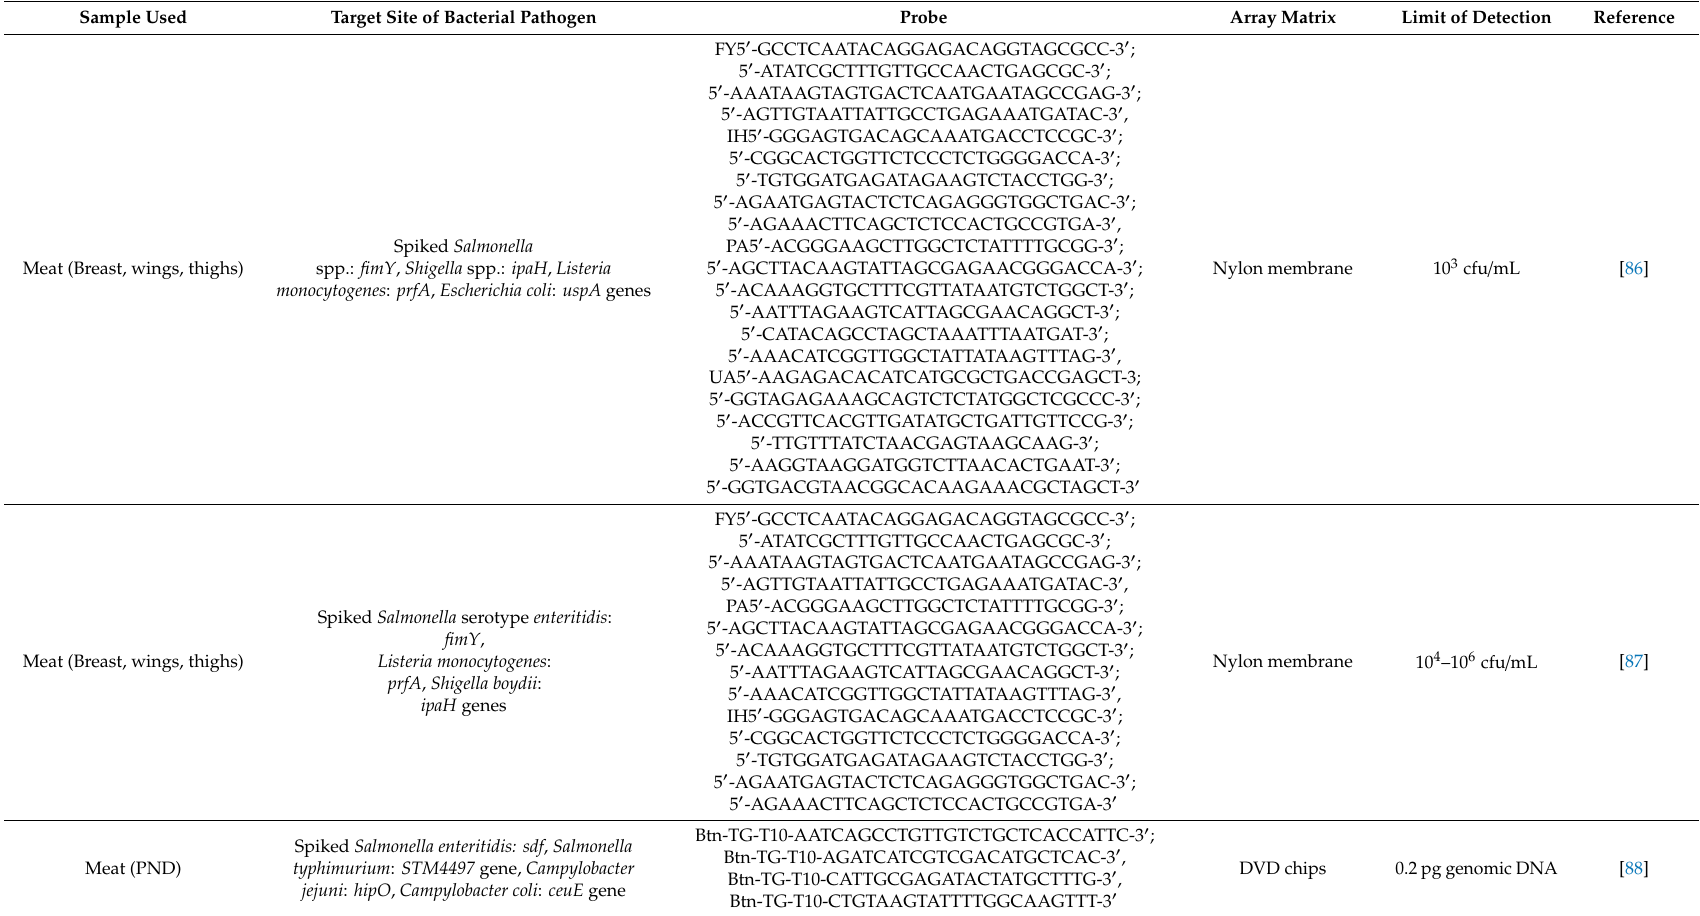
Table 5. Array-based approaches used for the detection of chicken-borne